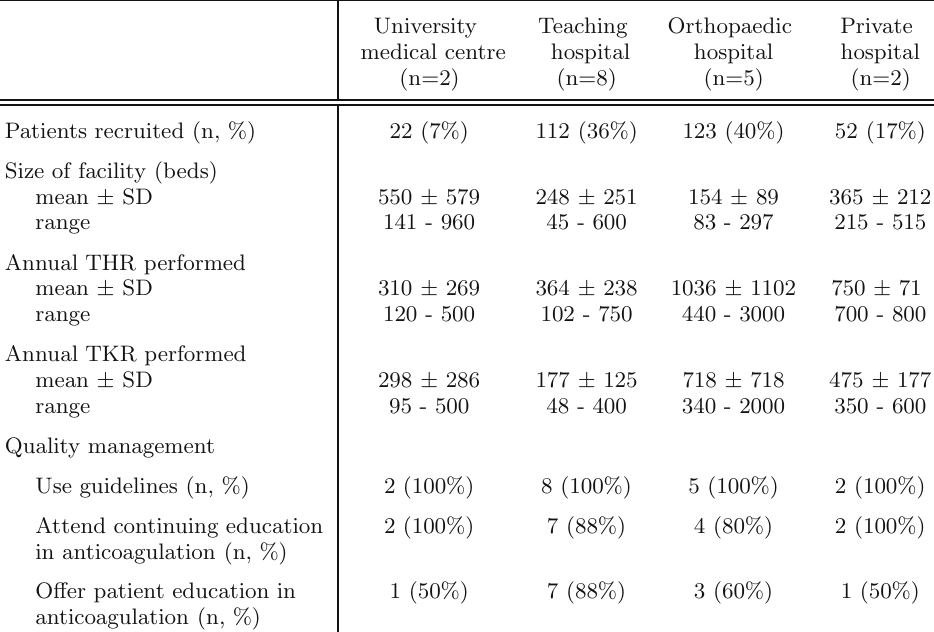
Table 3 Characteristics of Recruiting